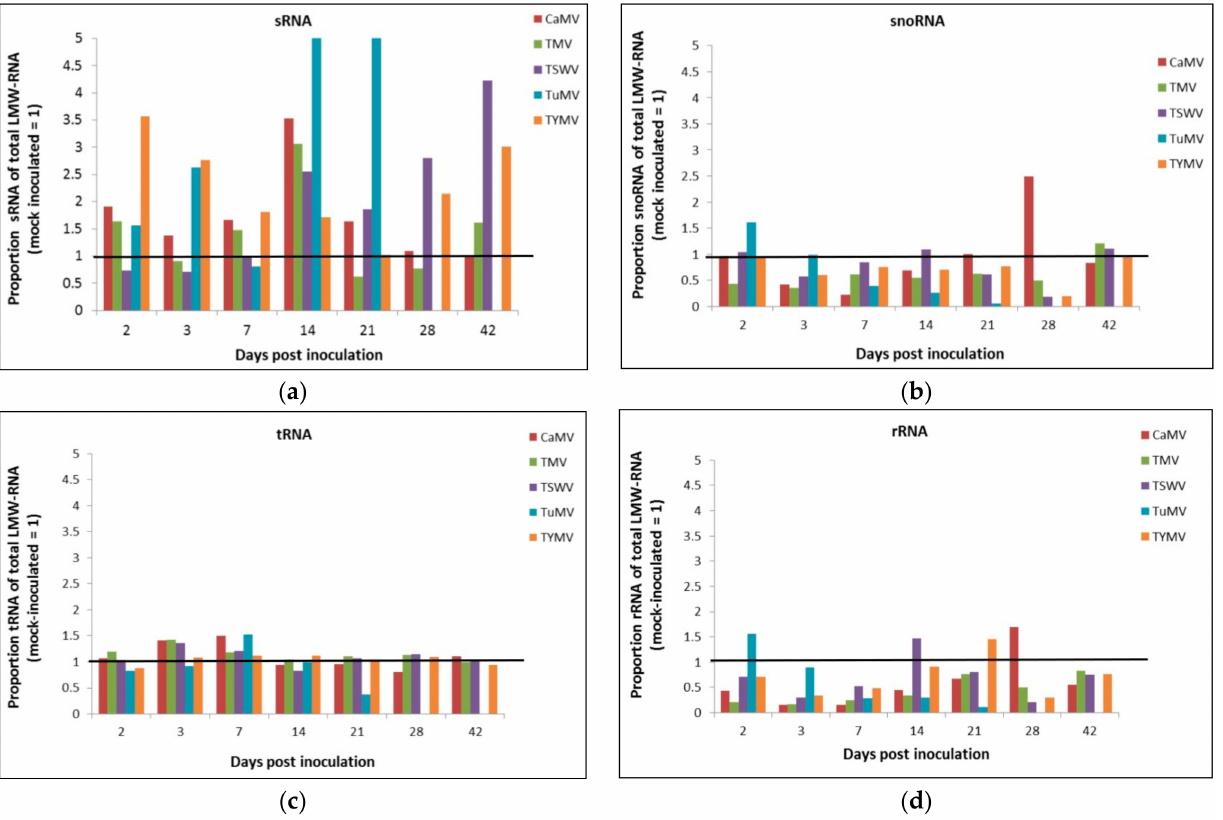
Figure 2. Proportion of low molecular weight (LMW)-RNA components of total LMW-RNA com- pared to averaged mock-inoculation rescaled to 1.0. ( a ) small RNA (sRNA), ( b ) small nucleolar RNA (snoRNA), ( c ) transfer RNA (tRNA), and ( d ) ribosomal RNA (rRNA). CaMV, cauliflower mosaic virus; TMV, tobacco mosaic virus; TSWV, tomato spotted wilt virus; TuMV, turnip mosaic virus; TYMV, turnip yellow mosaic